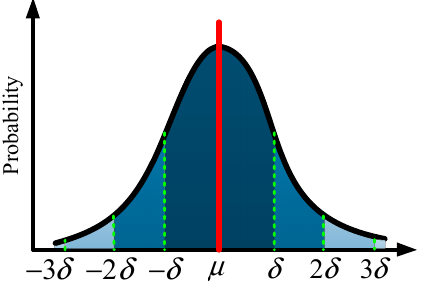
Figure 6. Gaussian distribution and subintervals of gradient directions.